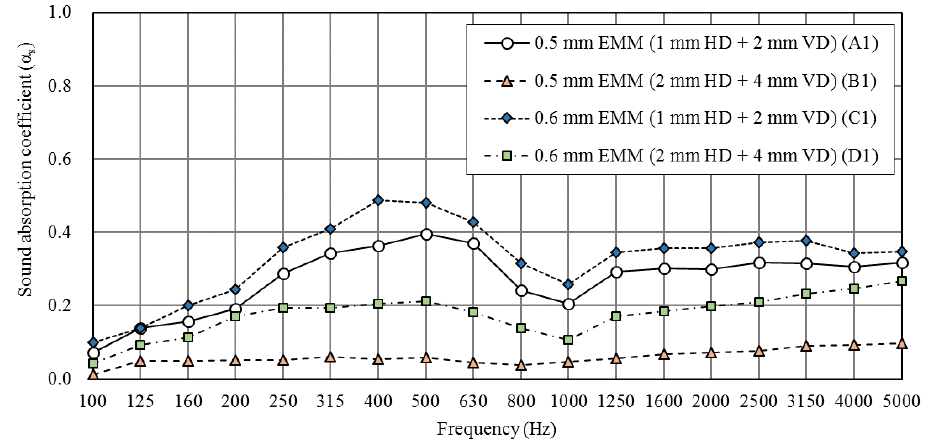
Figure 6. The sound-absorption coefficient of EMM with a 210 mm cavity.